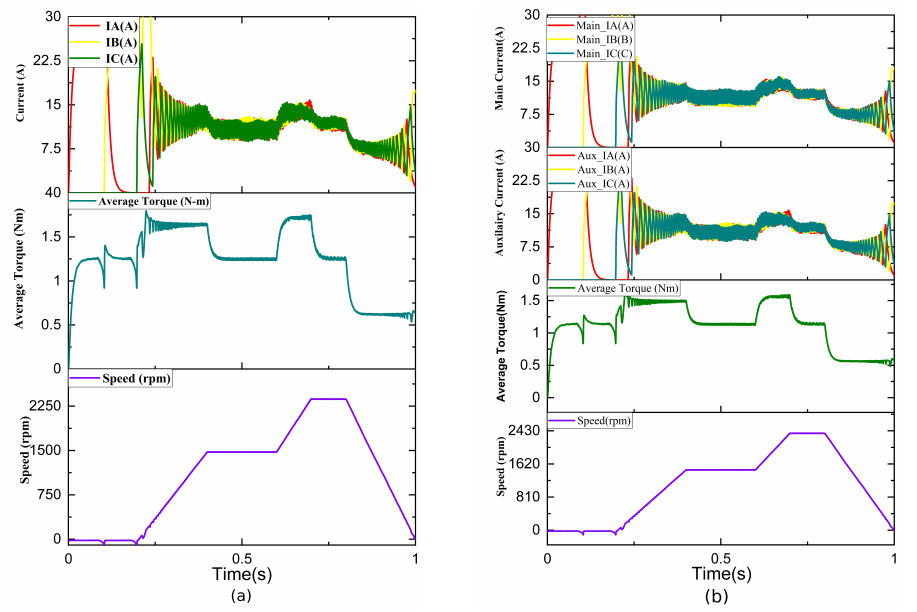
Figure 10. Closed-loop variable-speed current control strategy: ( a ) conventional SRM and ( b ) HESRM; the curves are current (A), torque (N-m), and speed